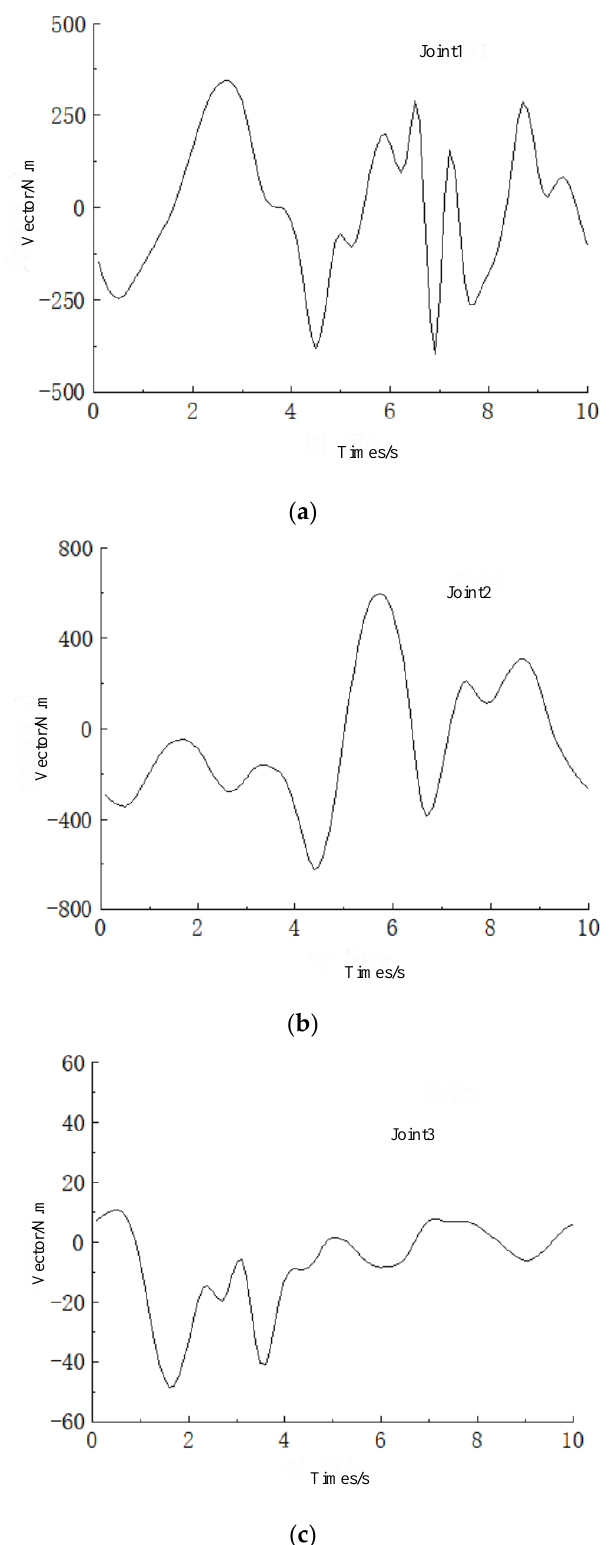
Figure 3. The excitation trajectory of the first three joints of the RS010N robot. ( a ) First joint motivation. ( b ) Second joint motivation. ( c ) Third joint motivation.